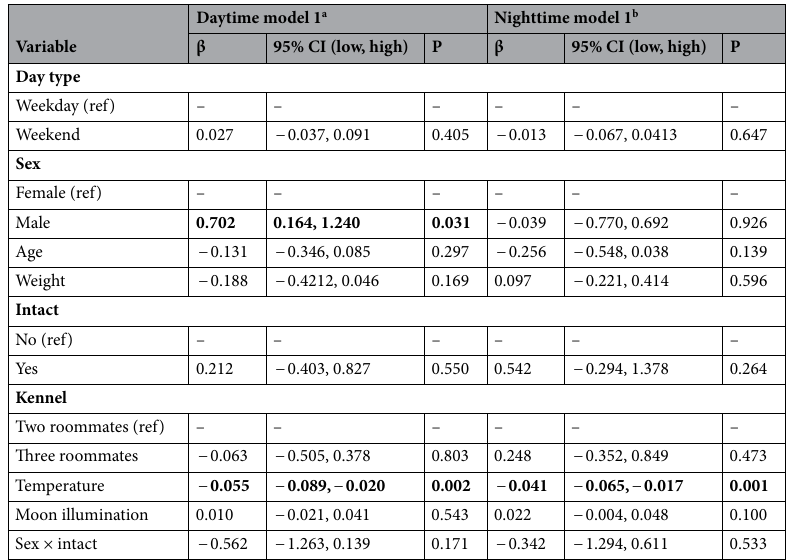
Table 1. Summary of multivariable approach using linear mixed-effects models in 29 Haliburton dogs. Daytime model analysis of MotionWatch activity counts from 6:00 a.m. to 8:59 p.m. while nighttime model includes analysis of MotionWatch activity counts from 9:00 p.m. to 5:59 a.m. a Overall model fit compared to the null model: N = 870, χ 2 = 30.66, P < 0.001. Marginal R 2 = 0.221, conditional R 2 = 0.479. b Overall model fit compared to the null model: N = 870, χ 2 = 19.98, P = 0.018. Marginal R 2 = 0.122, conditional R 2 = 0.622. Significant effects (P < 0.05) are in bold.